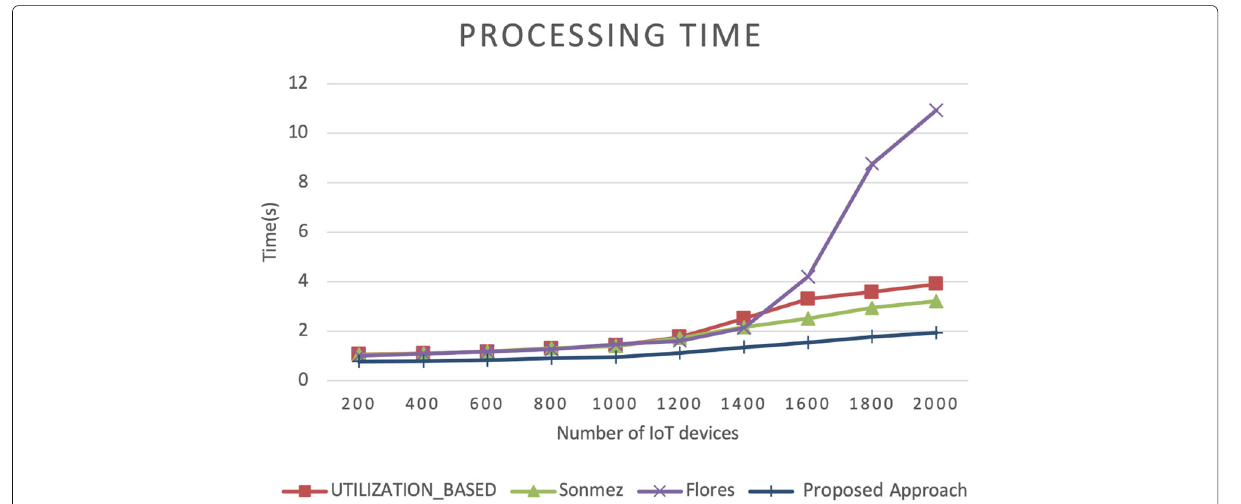
Fig. 10 The processing time of the proposed approach with other related approaches